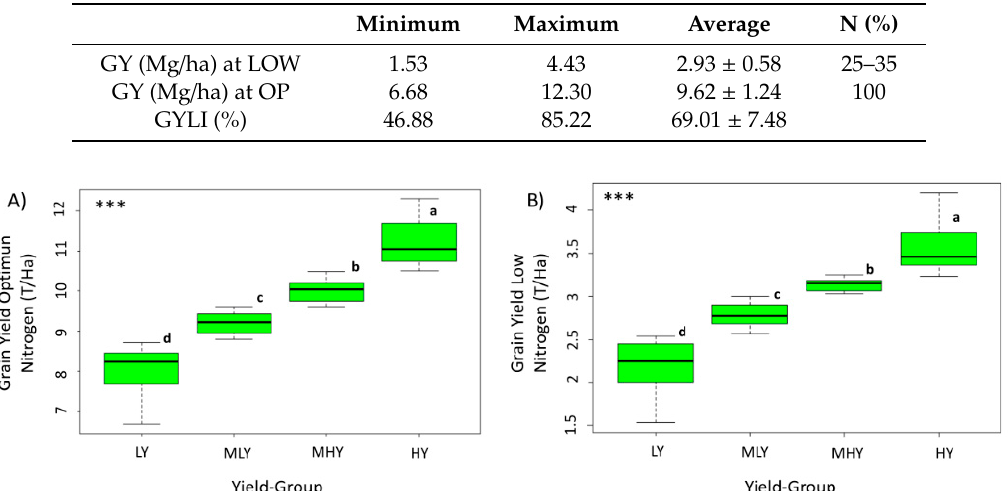
Table 1. Minimum, maximum, and average of grain yield (GY) and percentage of Nitrogen (N) of the two different treatments: LOW and optimum nitrogen (OP). Minimum, maximum, and average of grain yield loss index (GYLI).